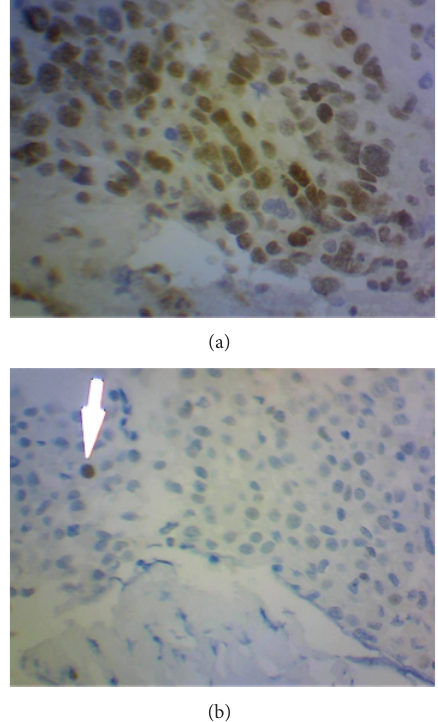
Figure 1: The upper panel (a) shows a diffuse positive MGMT con- trol (glioblastoma). The lower panel (b) corresponds to a negative MGMT immunostaining of macrocorticotropinoma in patient